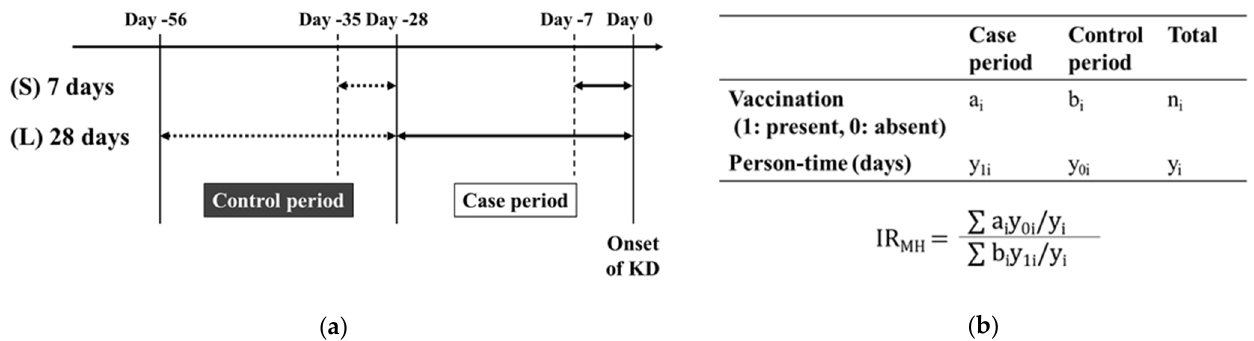
Figure 1. Period setting and the analysis of the case-crossover study. ( a ) Definition of the case and control periods. Case periods were defined as the 7 days (S) or 28 days (L) before the date of the onset of KD. Control periods were defined as 29 to 35 days (S) or 29 to 56 days (L) prior to the onset of KD. ( b ) A table contained the vaccination status and person-time per subject (indicating as stratum “i”) to calculate the Mantel-Haenszel incidence ratio (IR MH ) as the pooled estimate.